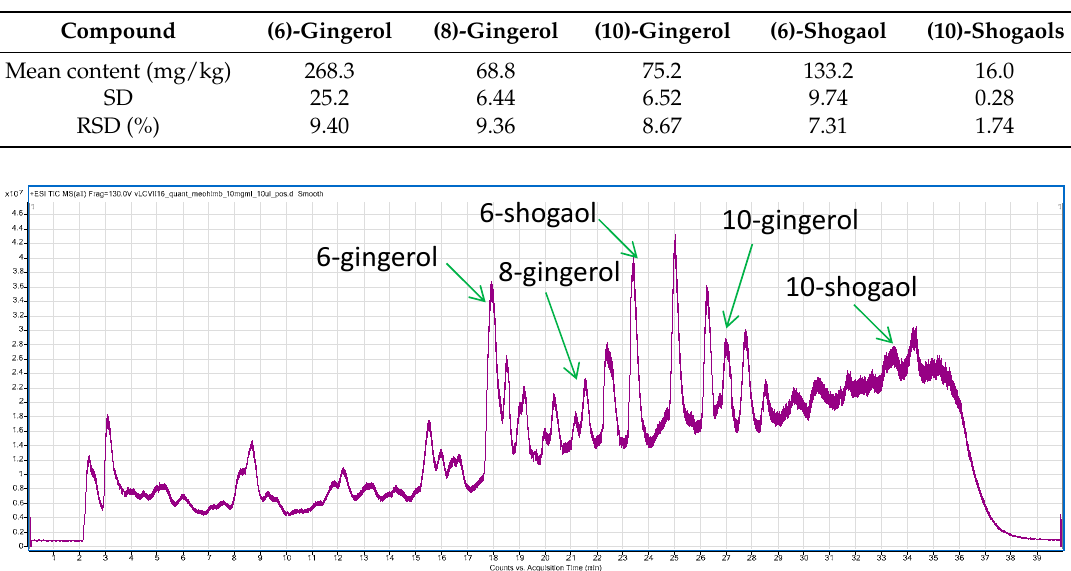
Figure 1. TIC spectrum of Zingiber officinale rhizome ethanolic extract with the analyzed phenolic compounds marked in accordance with their retention times.